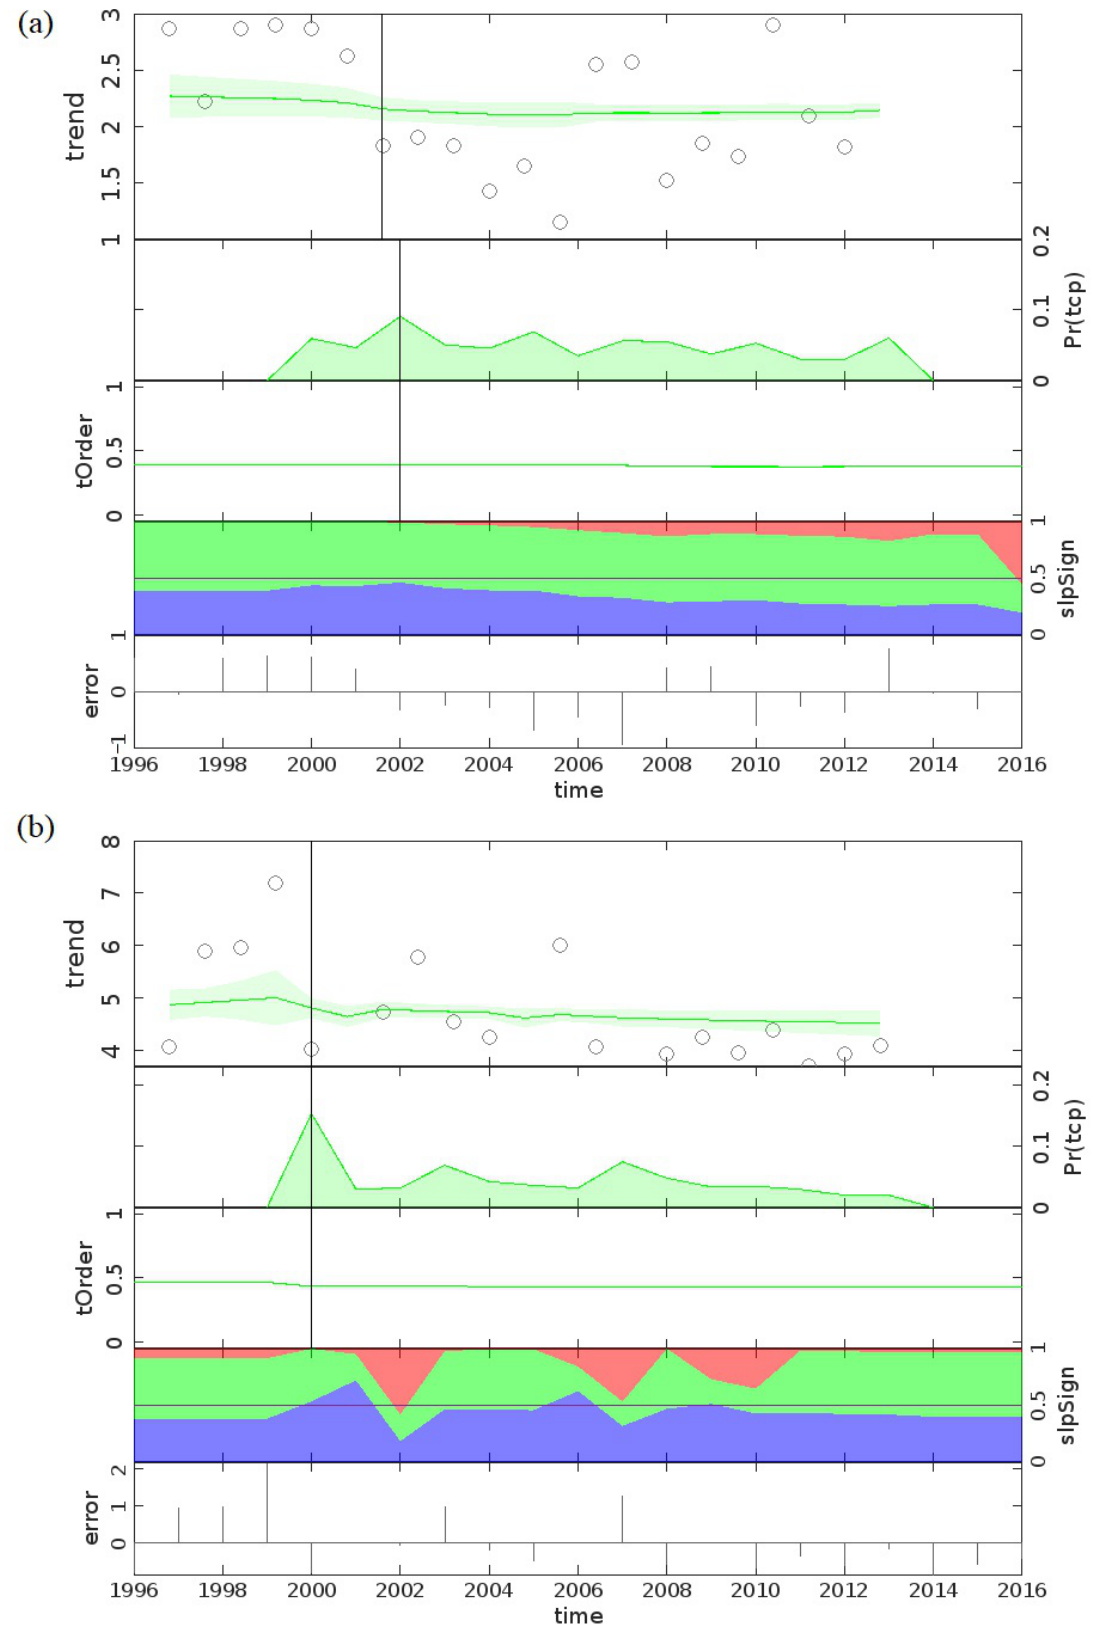
Figure 6. BEAST plot specifically for well locations ( a ) Konnakuzhi-iii and ( b )